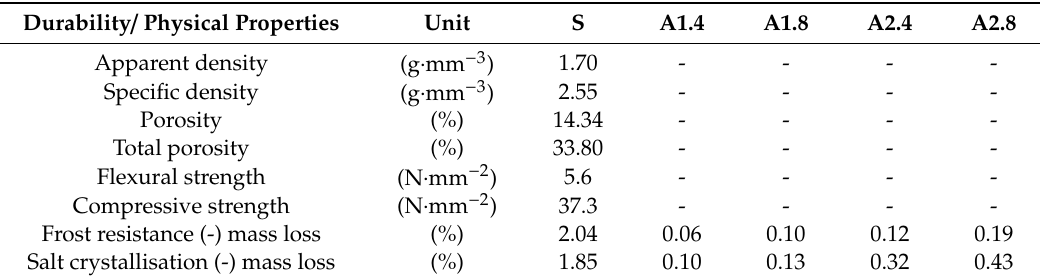
Table 6. Durability and physical properties of lightweight